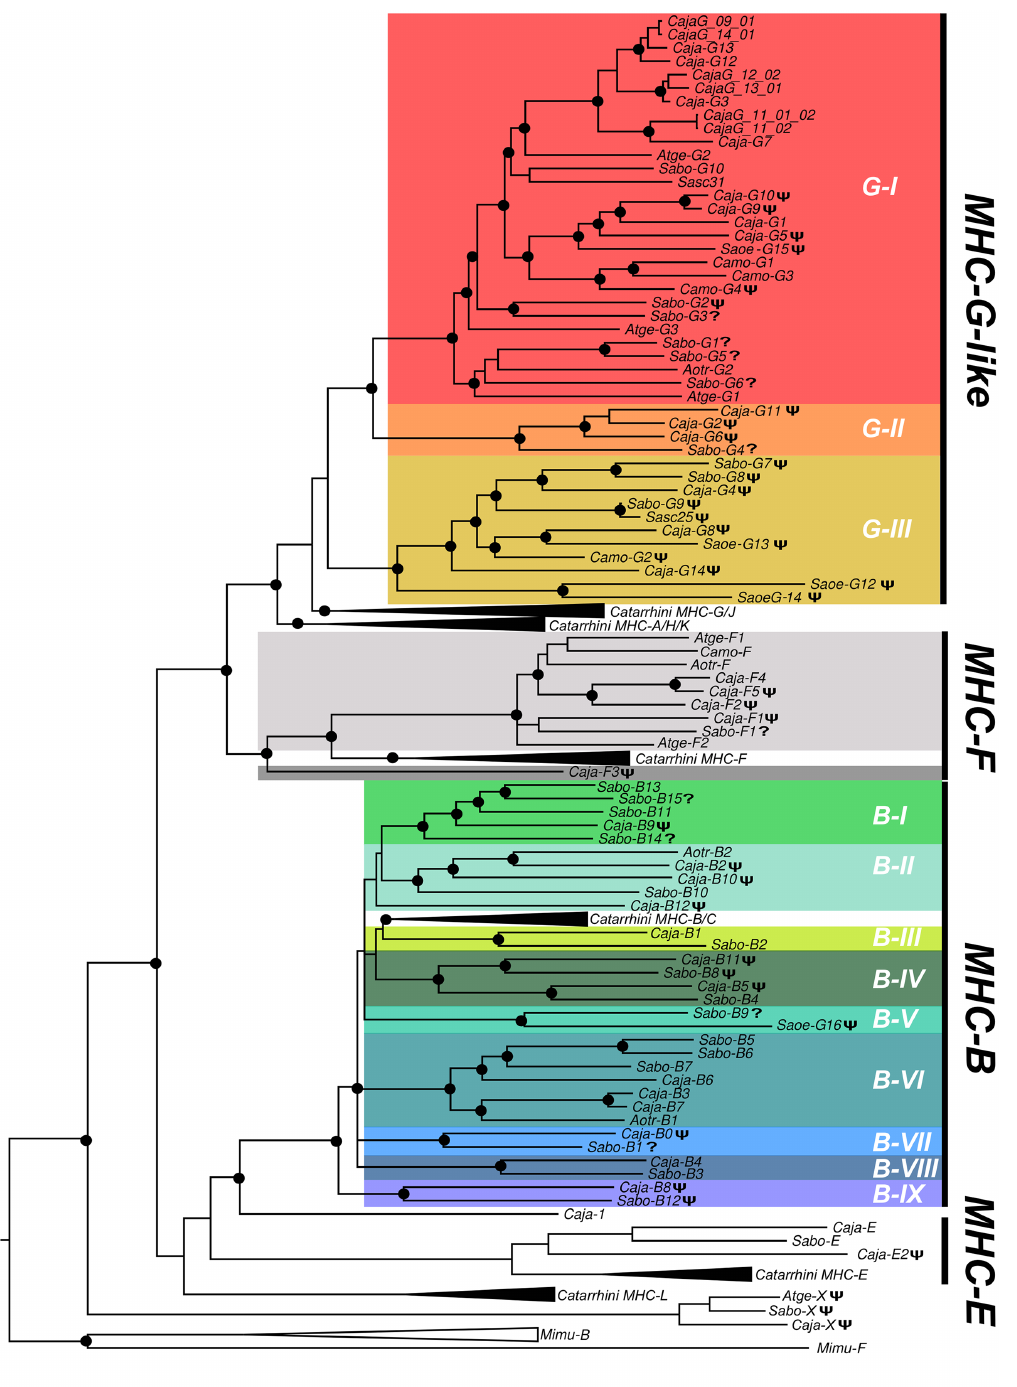
Fig 2. Bayesian phylogenetic tree based on introns 1 – 8 from primate MHC class I genes and pseudogenes. Black dots at the branching points indicate a support with a posterior probability greater than 0.9. A phi ( Ψ ) symbol in front of a sequence name indicates pseudogene and a question mark (?) indicates an incompletely sequenced gene. Catarrhini clades include human and Rhesus monkey MHC class I sequences, whereas MHC class I sequences from the grey mouse lemur Microcebus murinus (Mimu) were used as outgroup. Lineages are indicated by a G ( MHC-G-like ) or a B ( MHC-B ), followed by a Roman number. Caja, Callitrhix jacchus ; Sabo, Saimiri boliviensis ; Sasc, Saimiri sciureus ; Camo, Callicebus moloch ; Atge, Ateles geoffroyi ; Saoe, Saguinus oedipus ; Aotr, Aotus trivirgatus . Accession numbers for published Platyrrhini MHC class I sequences used in the analysis are listed in S3 Table.